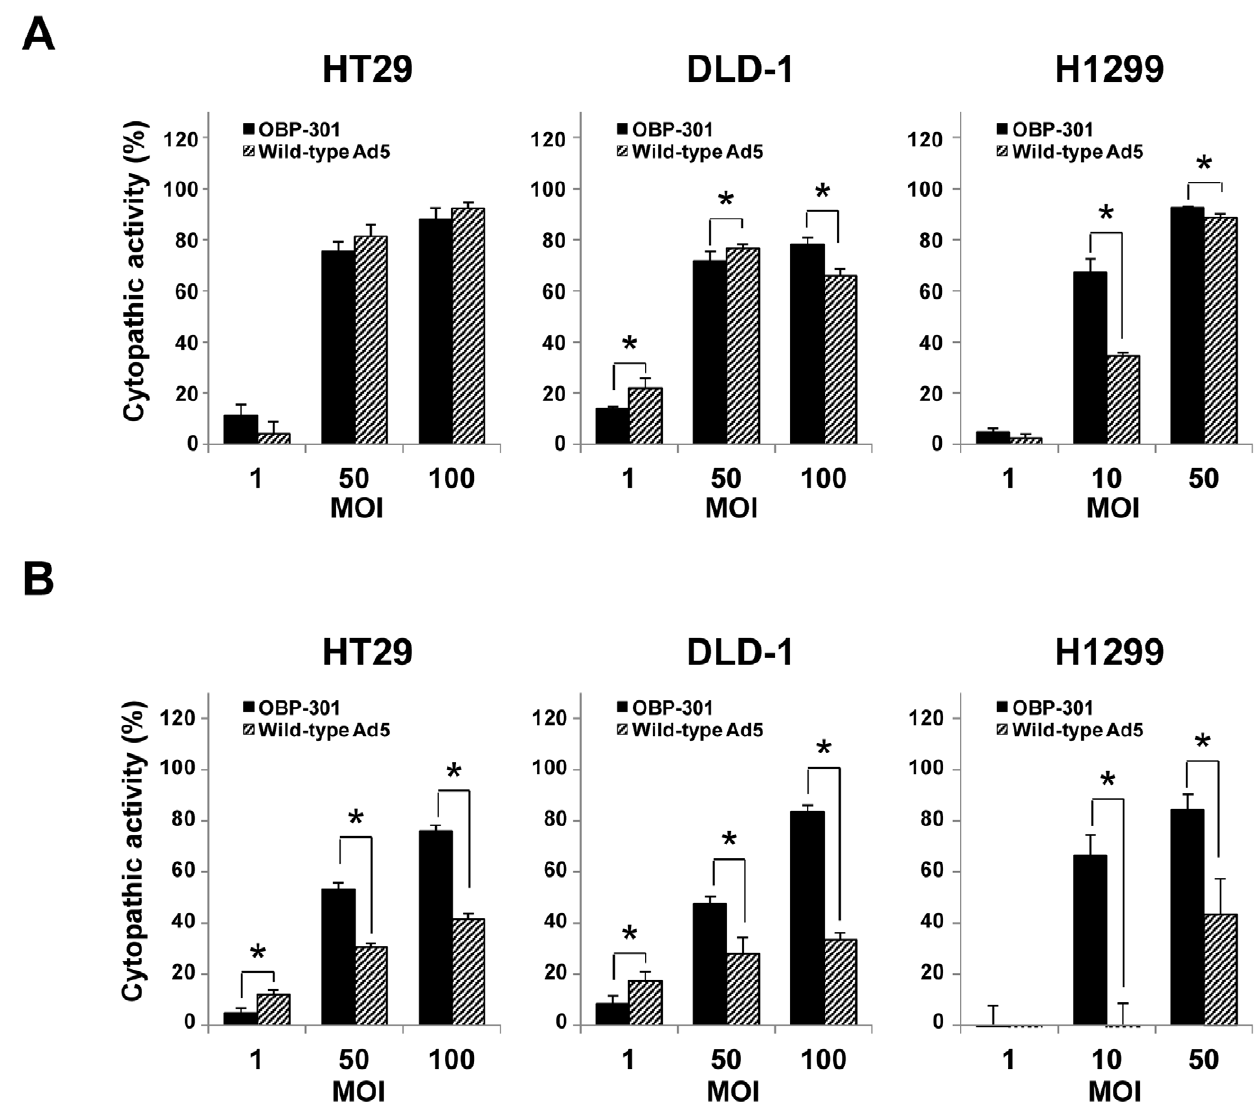
Figure 3. Cytopathic effect of OBP-301 and wild-type adenovirus serotype 5 (Ad5) under normoxic or hypoxic conditions. Cells were infected with OBP-301 (solid bars) or wild-type Ad5 (diagonal bars) at the indicated MOIs under normoxic ( A ) or hypoxic ( B ) conditions for 3 days. Cell viability was determined using an XTT assay. Cell viability was calculated relative to that of mock-treated cells, whose viability was set at 100%. Cytopathic activity was further calculated using the following formula; Cytopathic activity (%)=100 (%) – cell viability (%). The results shown are the mean values 6 SD of quadruplicate experiments. Statistical significance (*) was determined as P , 0.05 (Student’s t test).